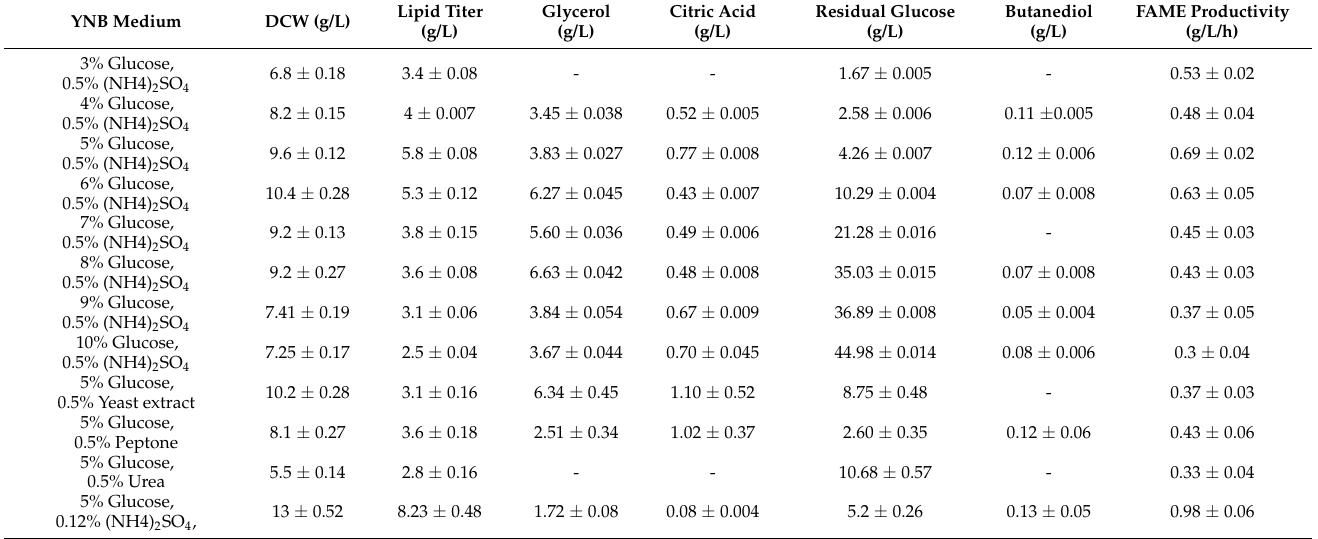
Table 1. Comparative study of lipid, FAME productivity and other by-products generated by R. toruloides during cultivation on different glucose and nitrogen